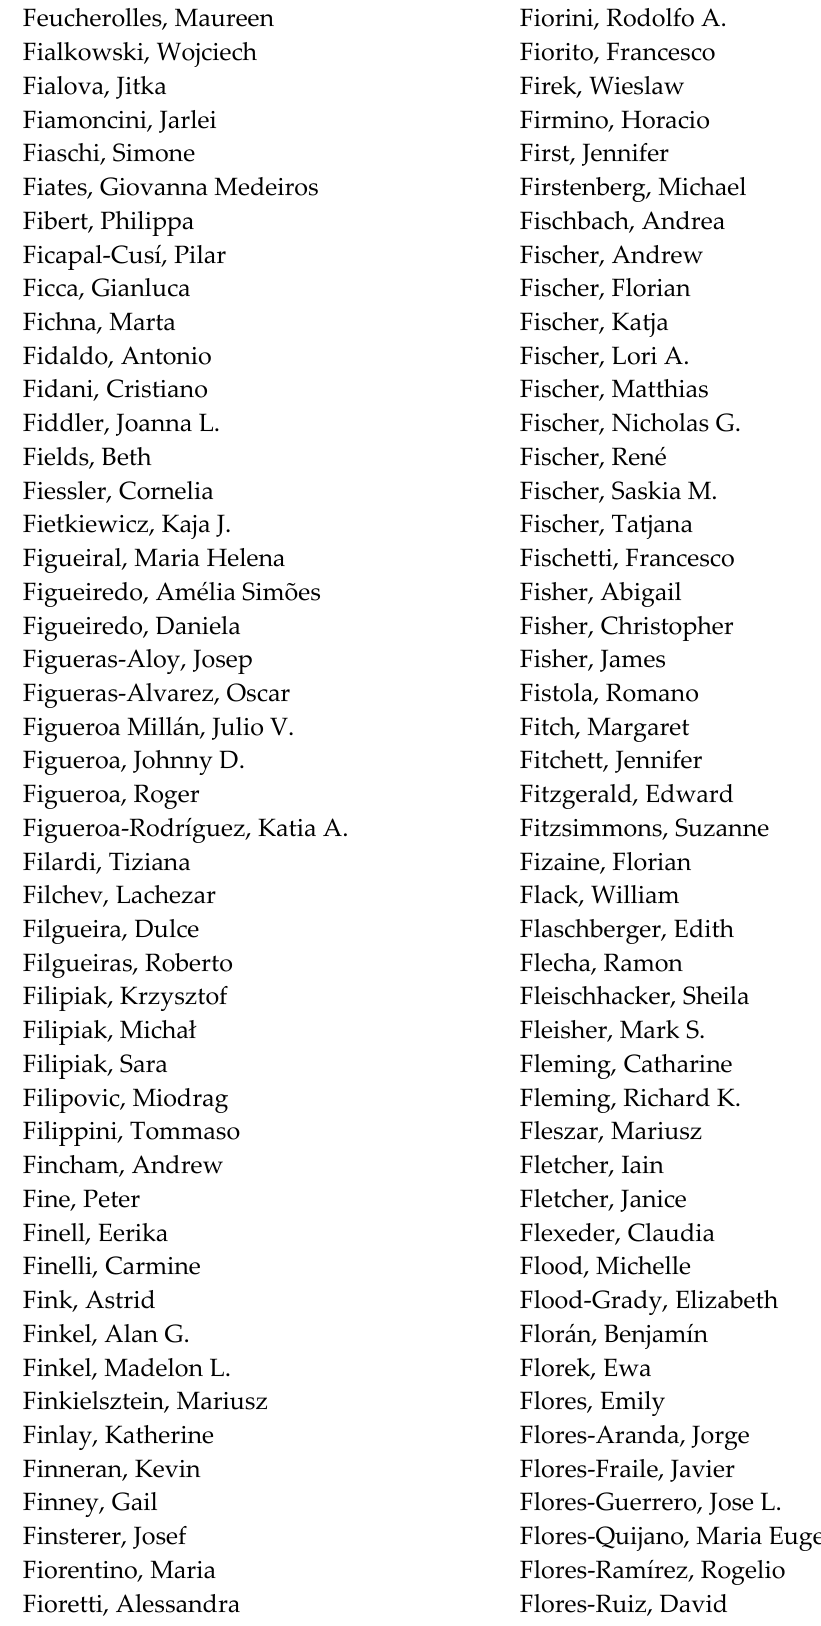
Fink, Astrid Finkel, Alan